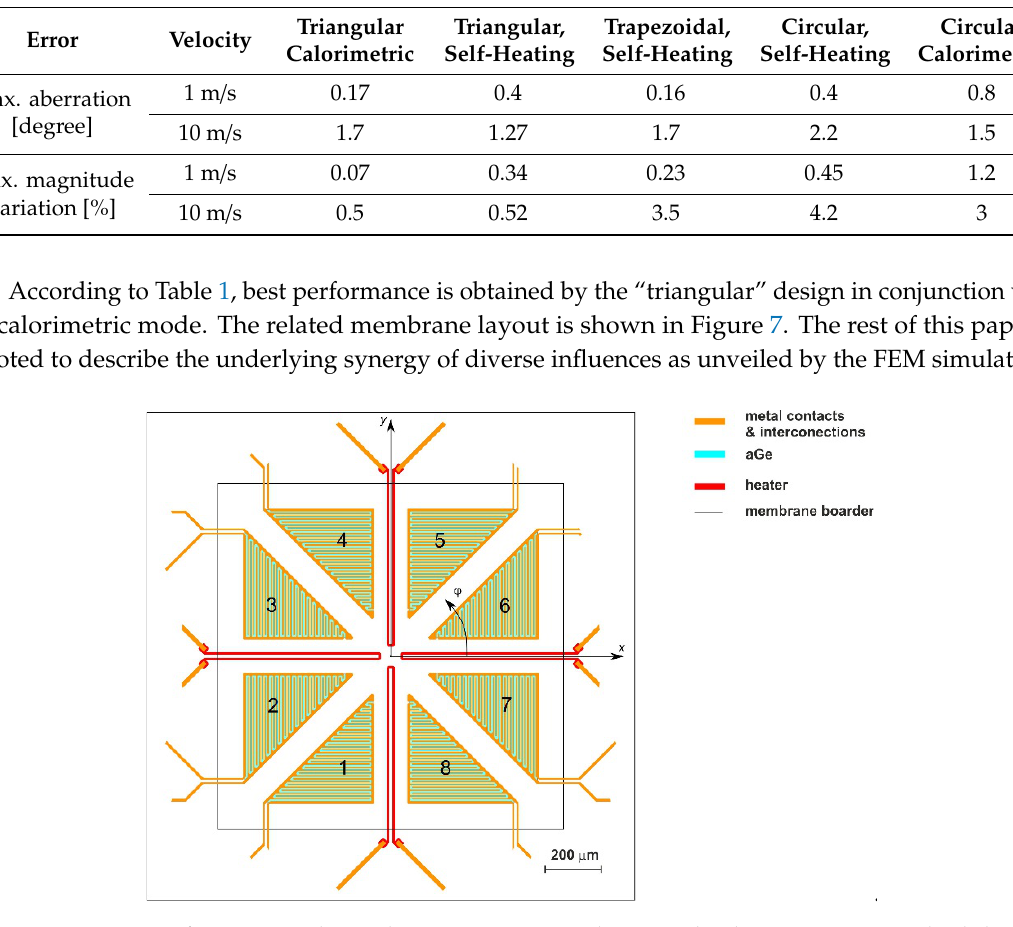
Table 1. Best performing membrane design / operating mode combinations. Maximum aberration is the largest di ff erence between the flow direction set for simulation and the angle ϕ calculated using simulation results and Equation (4). Maximum magnitude variation is the di ff erence between the velocity magnitude set for simulation and the calculated magnitude using Equation (4).